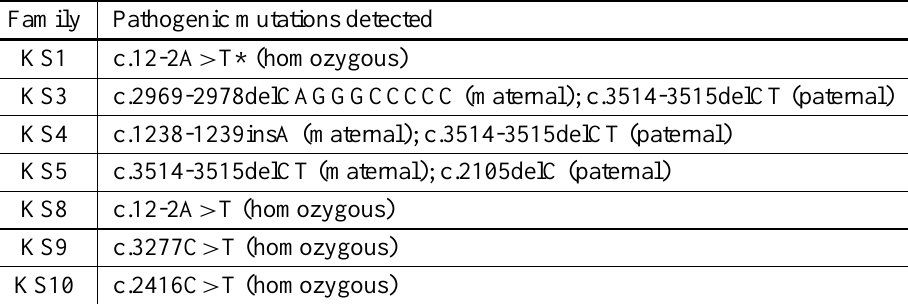
Pathogenic mutations found in KS patients. Nucleotide numbers are based on the reference sequence